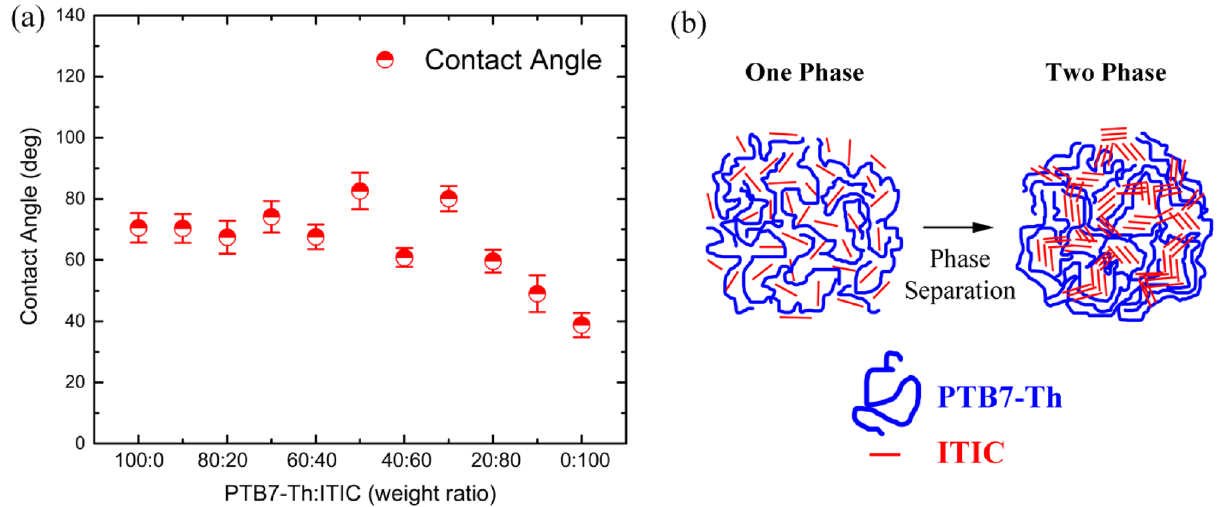
Figure 6. ( a ) Water contact angle for the PTB7-Th:ITIC films as a function of weight ratio of components. ( b ) The phase-separation process from one phase to two phase in the PTB7-Th:ITIC films by increasing weight fraction of